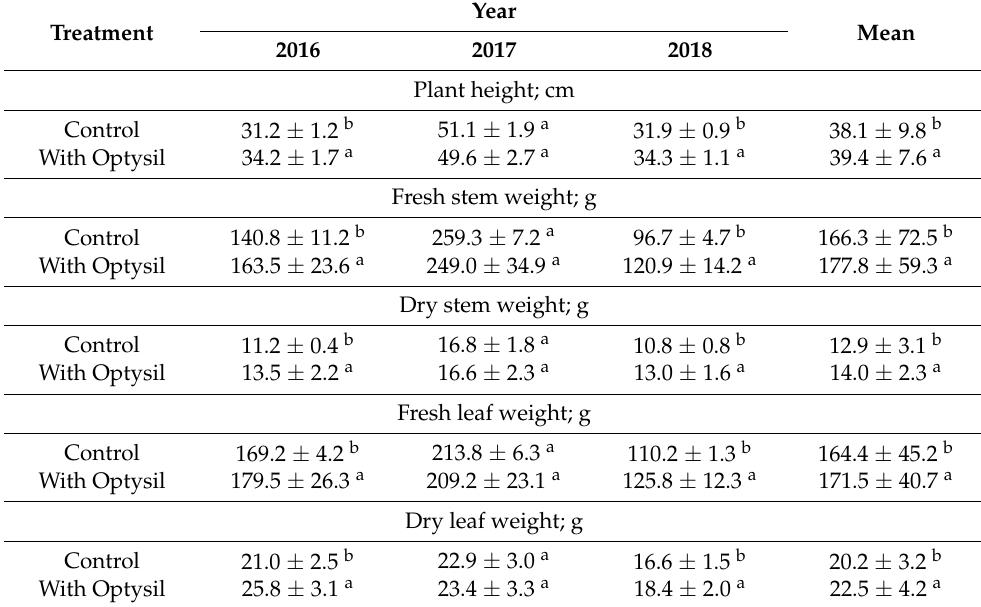
Table 3. Effect of Optysil on plant height and above-ground plant biomass.